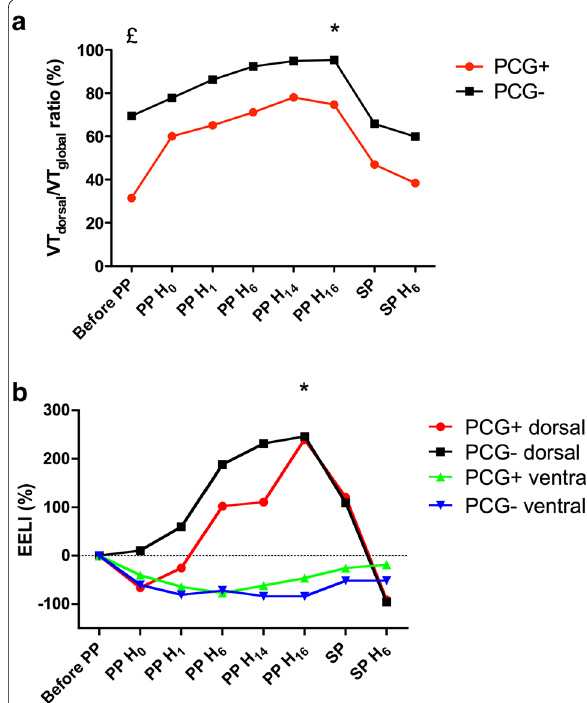
Fig. 3 a Variation of the median VT dorsal /VT global ; b variation of EELI compared to baseline in dorsal and ventral regions, for patients with an increase of the static compliance by patients with static compliance < 3 mL/cmH 2 O, respectively (PCG *p < 0.05 vs. baseline; £p < 0.05 between PCG